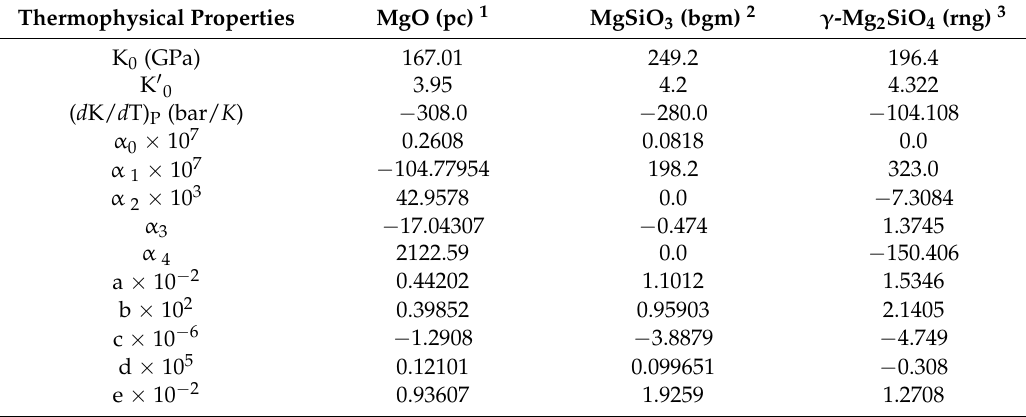
Table A3. Ab initio B3LYP thermophysical properties used to calculate the post-spinel phase equilibrium (cf. Equation (19)). K 0 = bulk modulus at the athermal